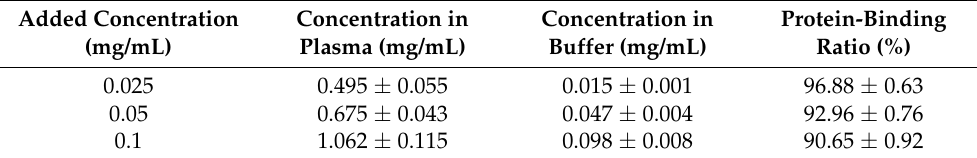
Table 4. The plasma protein binding ratios of azalomycin F at 24 h ( n = 3).